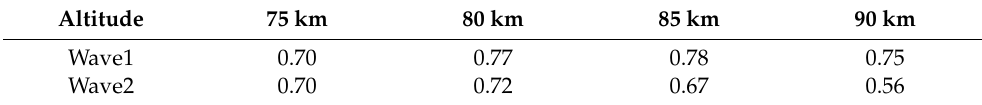
Table 1. Lag-1 autocorrelation coefficient between wave 1 and wave 2 in the